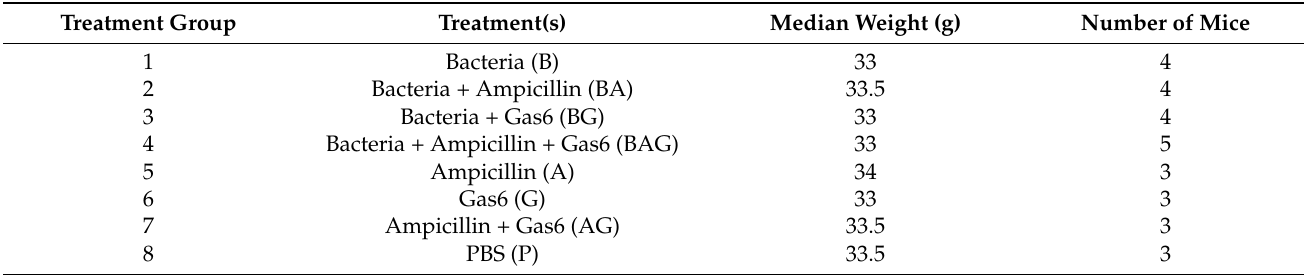
Table 1. Group of mice divided for treatments. 108 bacteria intraperitoneally injected, 200 mg/kg tail vein injected and 5 µ g growth arrest-specific 6 (Gas6) tail vein